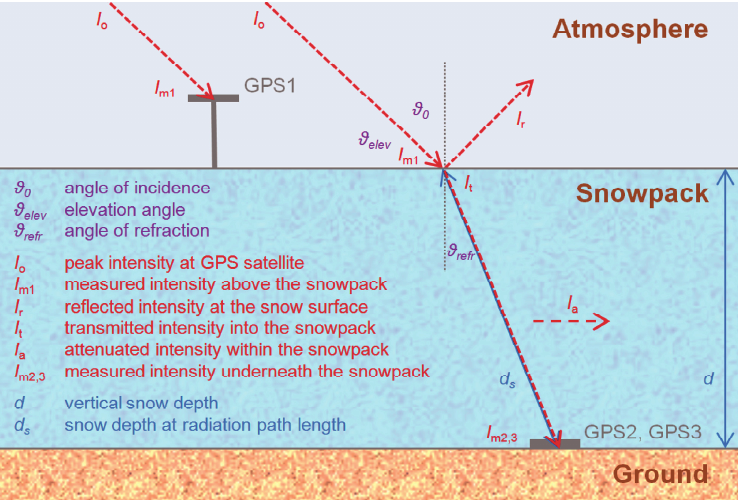
Figure 4. Overview of influences on the measured GPS intensity and radiation path length through snow, as well as the angle changes due to the reflection, refraction and attenuation processes. Only the direct signal paths are shown (in red); several multipath effects at and multiple bounces between the air/snow and snow/ground interfaces are